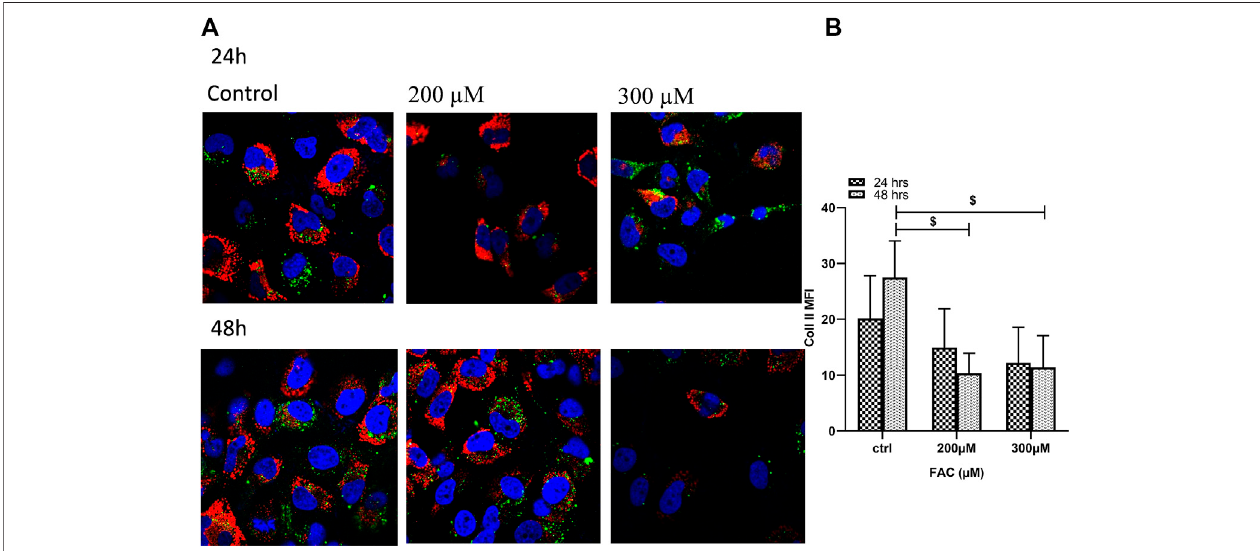
FIGURE4| IronoverloaddecreasescollagenIIproductioninchondrocytes. (A) ExpressionofcollagenIIbychondrocytestreatedwithFAC(200or300 µM)and24 or 48 h were assessed by immuno fl uorescence microscopy. Collagen II was labelled with Alexa fl uor ® 680 (Red), and nuclei were labelled with DAPI (Blue). Images were taken at ×100 magni fi cation. (B) Expression levels of collagen II by FAC treated chondrocytes in comparison to the controls shown as represented in the graph. Data shownarerepresentativeofthreeindependentexperiments.$denotesstatisticalsigni fi canceat p < 0.05aspertheindicatedgroup vs. itsuntreatedcontrolat48 h.